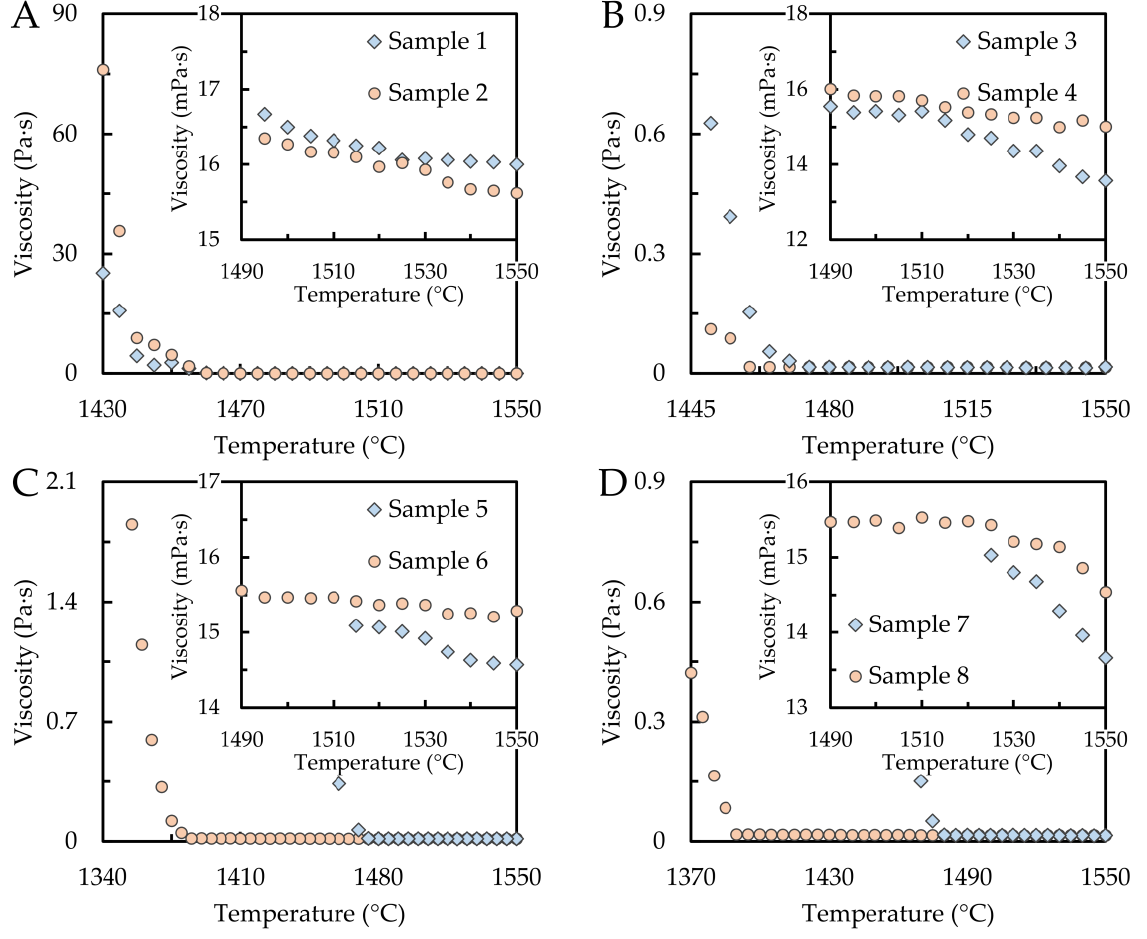
Figure 3. Temperature dependencies of viscosity for the samples ( A ) 1 and 2, ( B ) 3 and 4, ( C ) 5 and 6, and ( D ) 7 and 8.